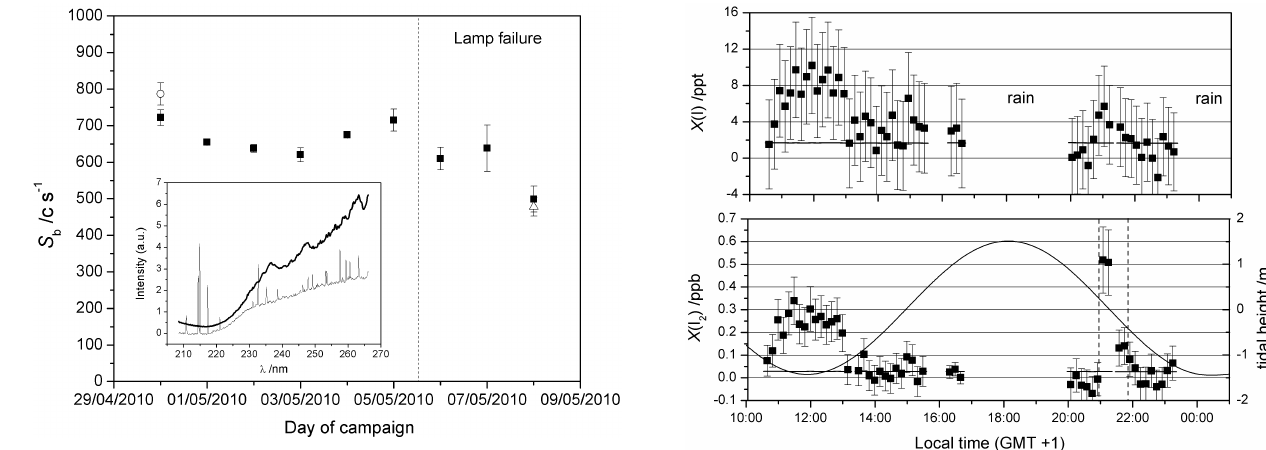
Fig. 11. Example of processed dataset (30 April) for a time reso- lution of 600s (300s background+300s direct sampling). Thick black lines under the data points indicate the counting statistics LOD for S/N = 1. The thin solid line in the bottom panel repre- sents tidal height. Vertical dashed lines in the bottom panel bracket a time interval where the pinhole was exposed to seaweed samples at short